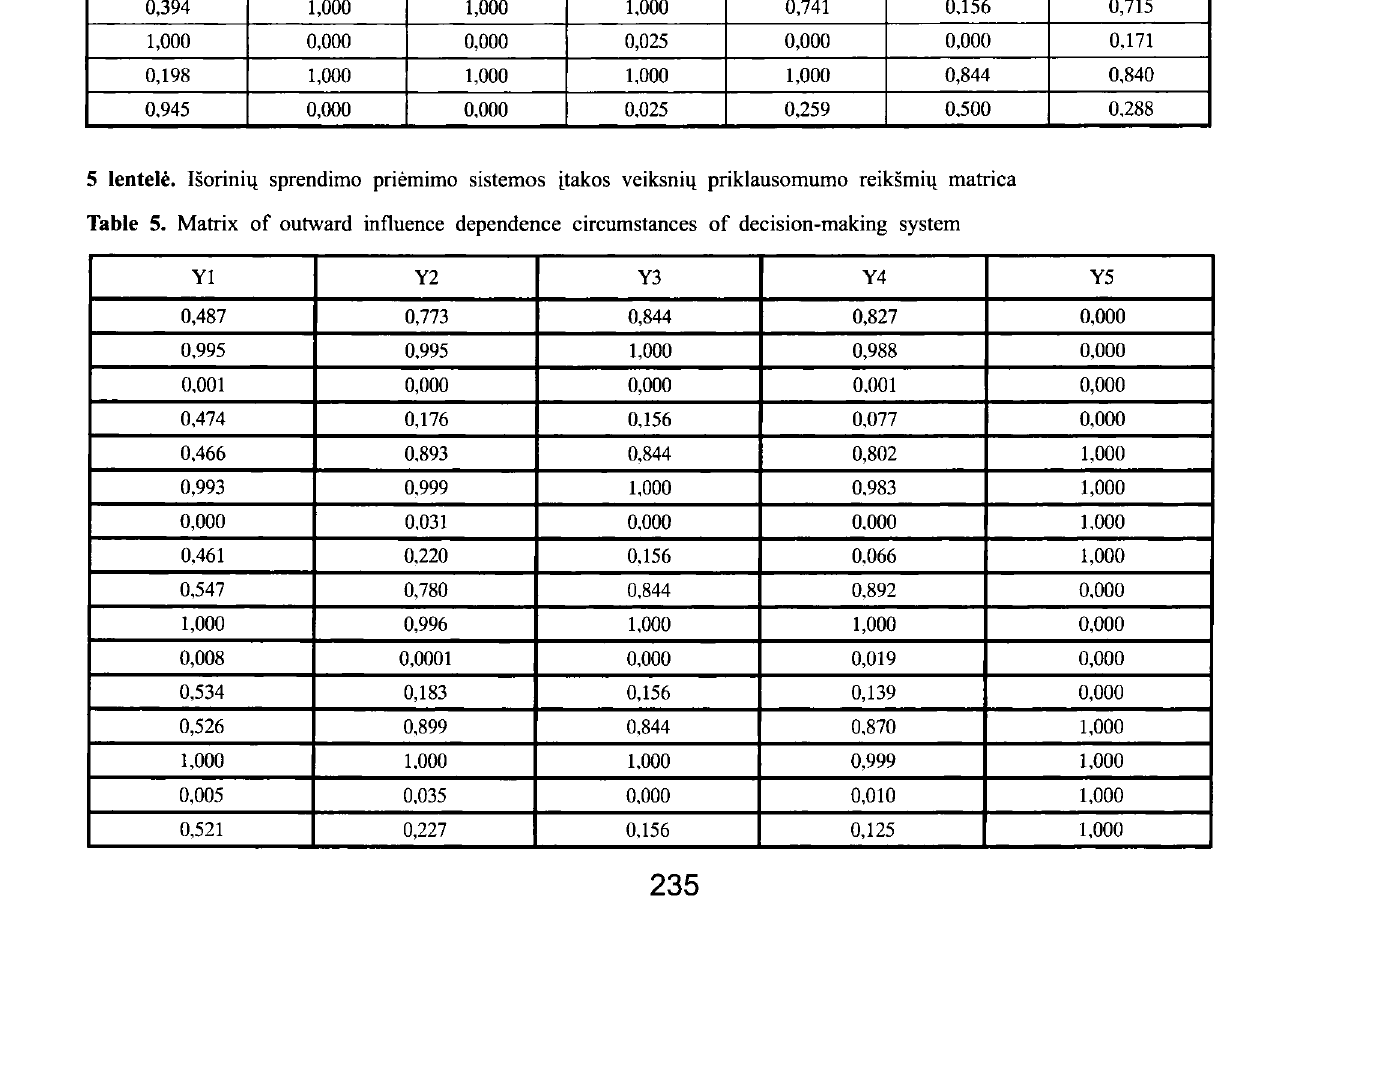
Table 4. Matrix of inherent influence dependence circumstances of decision-making system K1 K2 K3 K4 K6 JJ-,